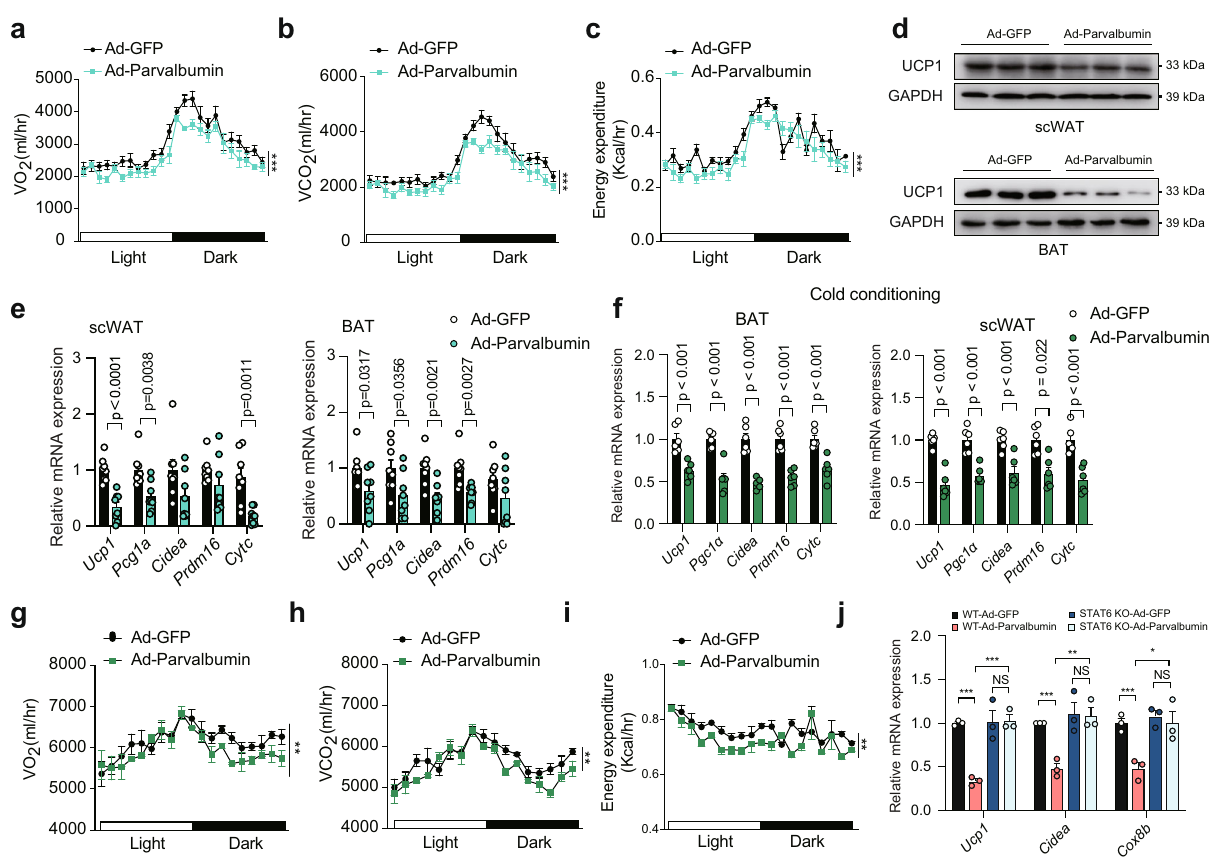
Fig. 6 Parvalbumin suppresses thermogenesis through M2 macrophages in mice. Male parvalbumin KO mice were intravenously injected with Ad- parvalbumin or Ad-GFP through the tail vein. VO 2 ( a ), VCO 2 ( b ), energy expenditure ( c ), UCP1 protein expression ( d ) and representative thermogenic gene expression ( e ) in scWAT and BAT were examined ( n = 8 per group). Male parvalbumin KO mice were intravenously injected with Ad-parvalbumin or Ad-GFP through the tail vein and fed under cold conditions. representative thermogenic gene expression ( f ) in scWAT and BAT, VO 2 ( g ), VCO 2 ( h ), and energy expenditure ( i ) were examined ( n = 8 per group). j Representative thermogenic gene expression in WT and STAT6 KO mice injected with Ad-GFP or Ad-parvalbumin ( n = 3 per group). P value: <0.0001, 0.0008, 0.0042, 0.0006, 0.0059, 0.0266. Data are represented as mean ± SEM. P values were determined by unpaired two-tailed Student ’ s t test ( e , f , and j ) and ANCOVA using weight as a covariable ( a – c and g – i ). * p < 0.05, ** p < 0.01, *** p < 0.001. Source data are provided as a Source Data fi